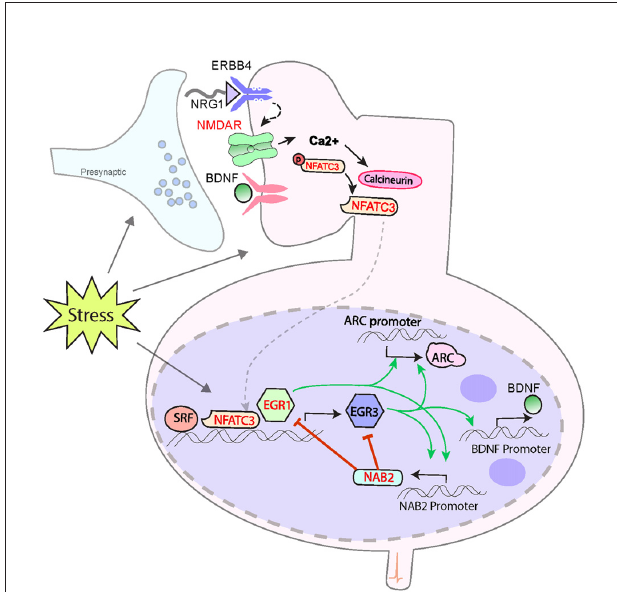
FIGURE 1 | Model for a biological pathway regulating memory, synaptic plasticity and schizophrenia risk. Numerous schizophrenia-risk associated proteins act either upstream or downstream of immediate early genes EGR3 and ARC . Red labels indicate proteins encoded by genes that map to the 108 loci for schizophrenia risk. Both EGR3 and ARC are activated by environmental events, such as stress, via activity-dependent activation of NMDARs. The resulting influx of Ca++ triggers Calcineurin/(CN) nuclear factors of activated T-cell (NFAT) signaling which can induce EGR3 expression. EGR3 positively regulates, and maintains expression of, ARC . NGFI-A Binding Protein 2 (NAB2), which is a transcriptional target of EGR3 and EGR1, binds to EGR proteins (EGR1, 2 and 3) to co-regulate expression of target genes. This action includes feedback inhibition of EGR1 and EGR3, and NAB2 itself, a critical element of the temporal regulation of activity-dependent genes. Additional proteins that interact in the pathway include NRG1 which, via binding to ERBB receptors, maintains expression of EGR3 (in muscle spindles), and has been shown to activate NMDARs. BDNF, via binding to Trk-B receptors, regulates EGR3-mediated expression of NMDAR subunit NR1. EGR3, in turn, is required for activity-dependent expression of BDNF. SRF is a transcription factor required for memory formation and long-term depression (LTD), which regulates expression of EGR3 (and EGR1). Perturbations in any components of this biological pathway are expected to result in deficient induction of EGR3, and its target genes, in response to neuronal activity, including that triggered by stress. Insufficient activation of this pathway in response to stimuli may result in poor memory formation and contribute to cognitive deficits. Deficient activation of the pathway in response to stress may also result in insufficient neuroprotective processes and thereby